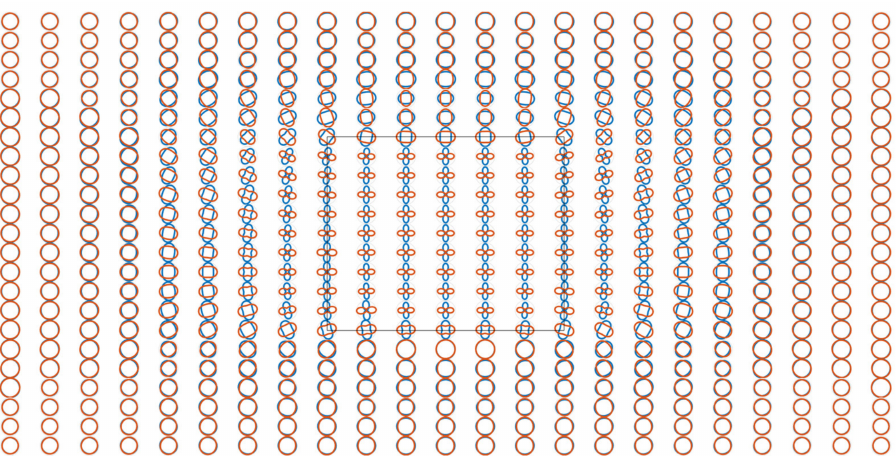
Figure 11. Polar plots of modified COMMEMI 3D-1A model for a frequency of 0.57 Hz. Principal conductivity rotation around the y -axis by 30 ◦ .